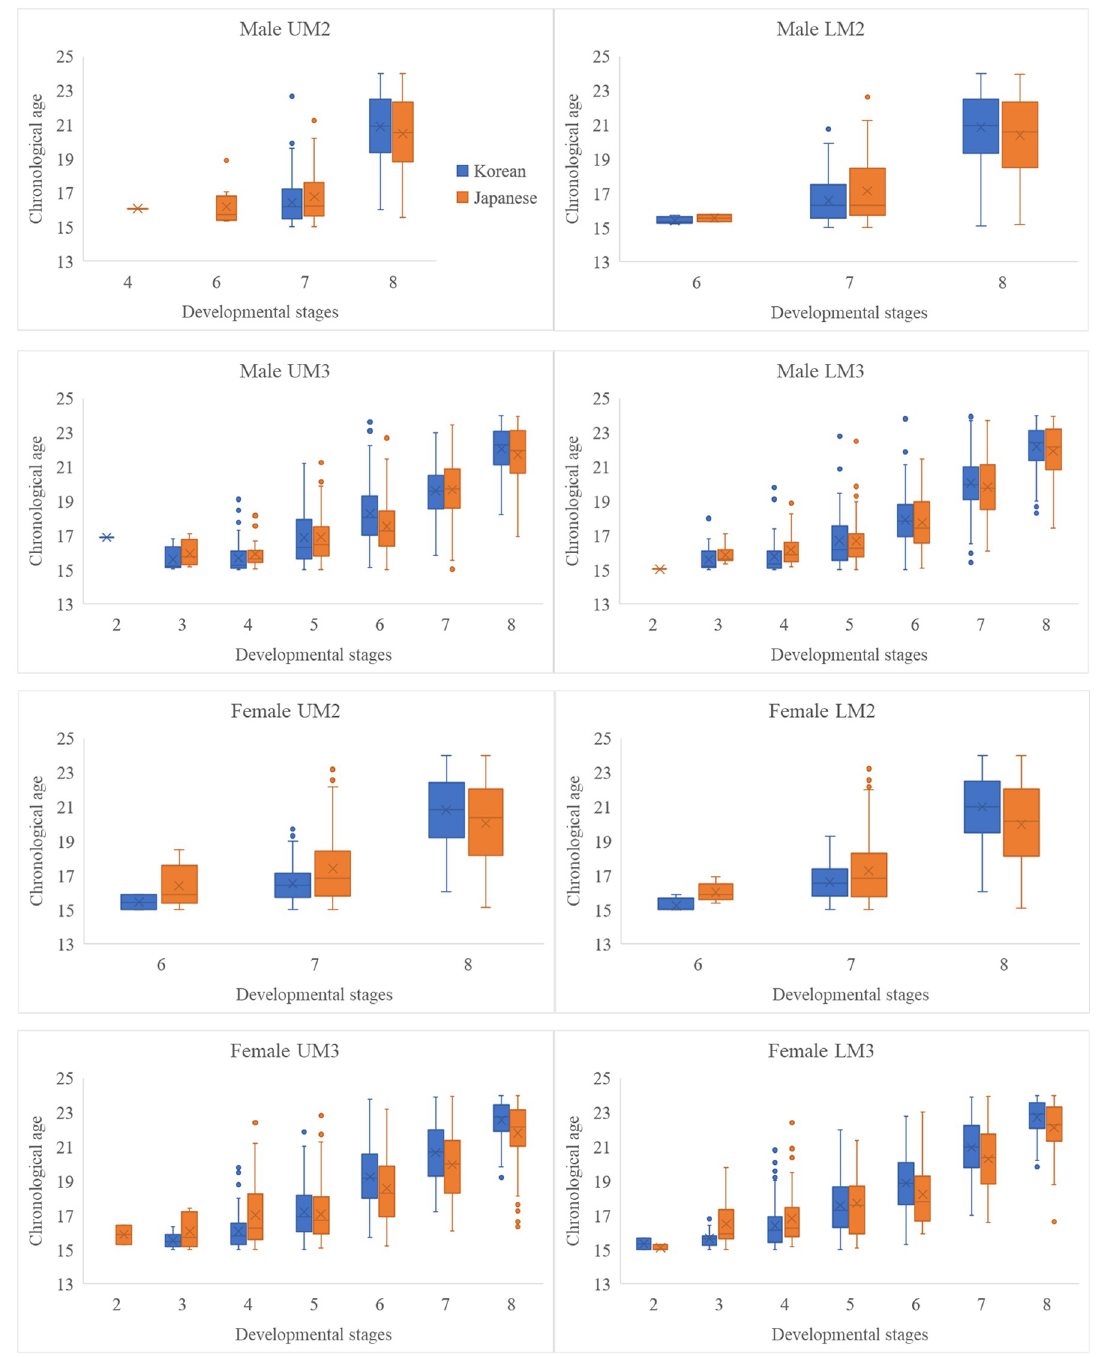
Fig 1. Box plots of the relationship between chronological age and developmental stage for M2s and M3s in both jaws. U, maxilla; L, mandible; Stages 1 to 8 indicate the scores of Demirjian developmental stages A to H. Blue and orange represent the Korean and Japanese populations,